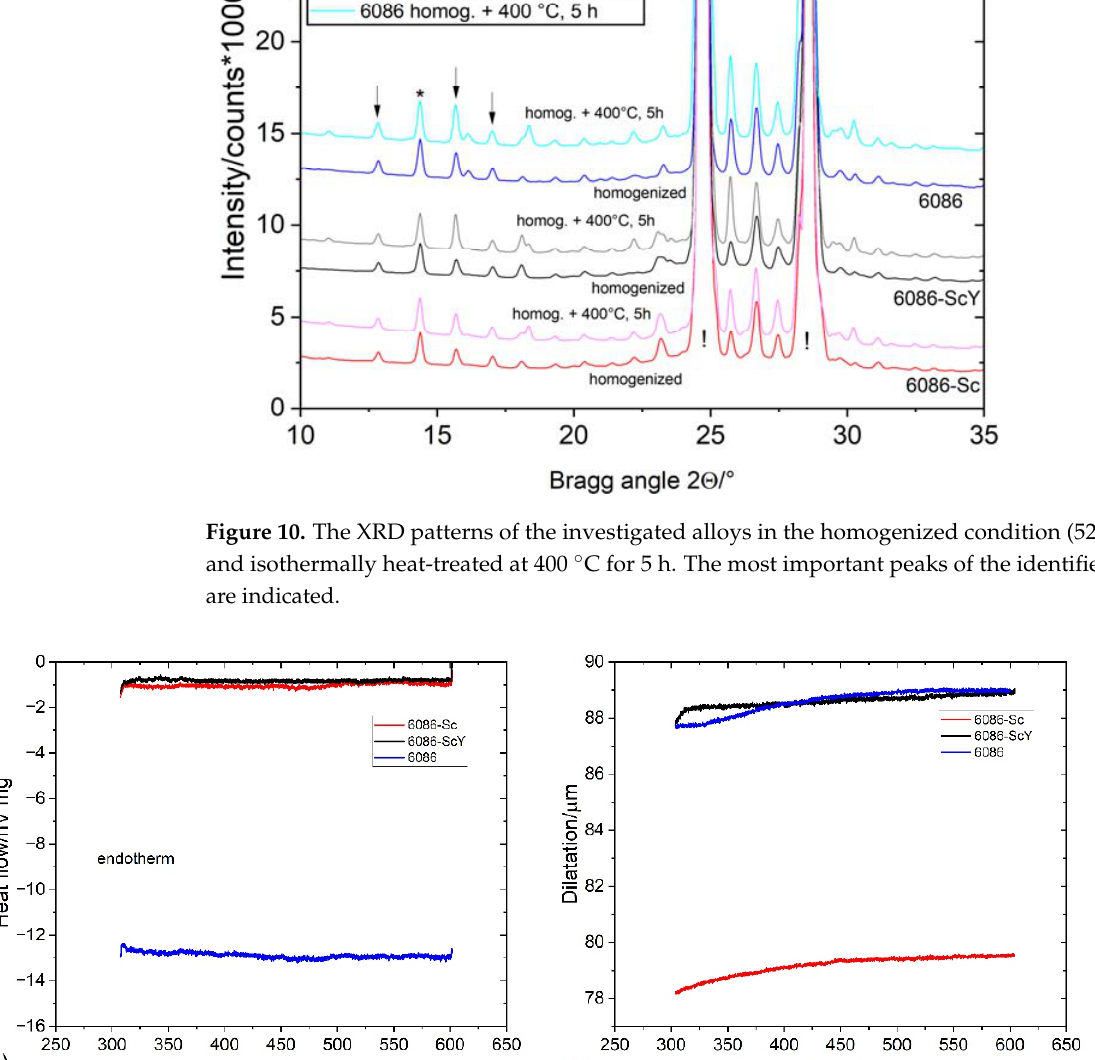
Figure 11. The thermal effect and dilatation of the homogenized samples during holding at 400 ◦ C for five hours. ( a ) Heat flow; ( b )